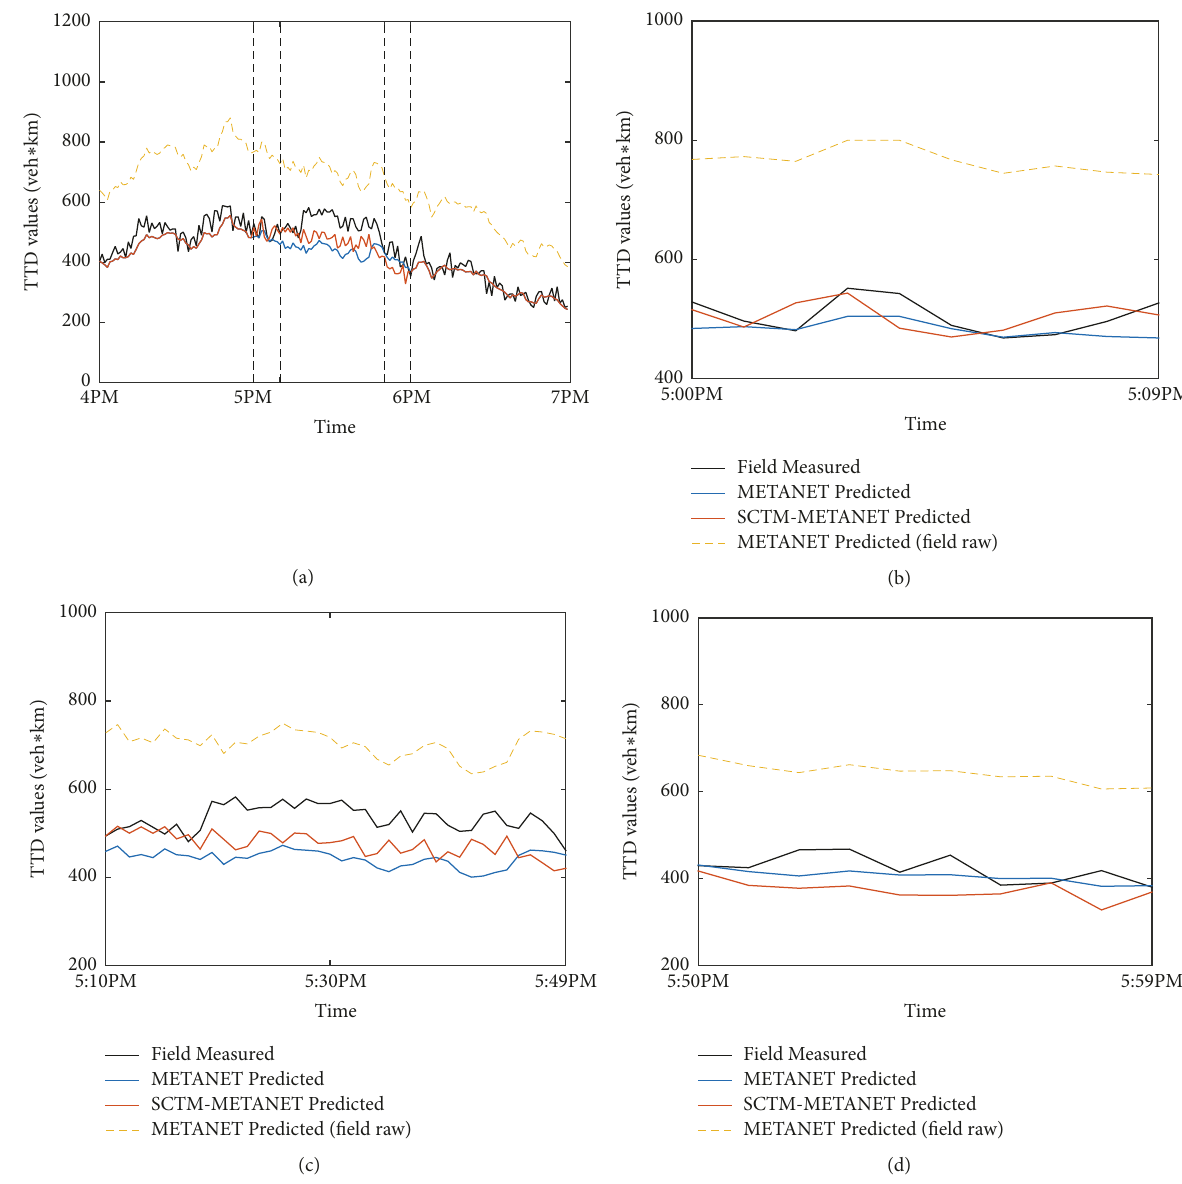
Figure 7: (a): Comparing field-measured TTD, original METANET, and SCTM-METANET predicted TTD. (b), (c), (d) detailed view of FC, CC, and CF